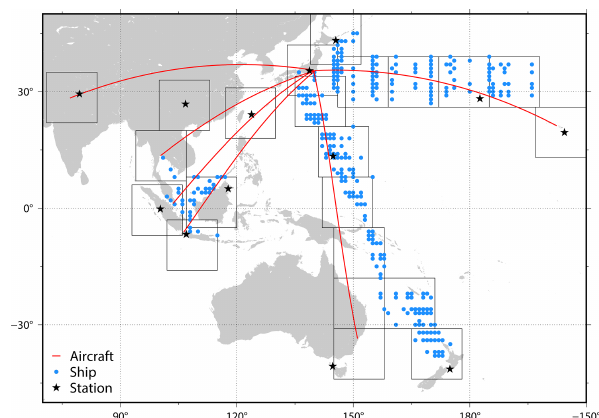
Figure 12. Main route or locations of the aircraft (red line), ship (blue dot), and station (black star) measurements. The areas for comparison with the GOSAT data are shown in boxes. Here, we only show the main routes of the aircraft measurements (Haneda/- Narita to Delhi, Bangkok, Singapore, Jakarta, Sydney, and Hon- olulu) accounting for more than 97%, although the remaining data contain the other routes (Haneda/Narita to Taipei, Kuala Lumpur, Denpasar, Cairns, Brisbane, and Guam).